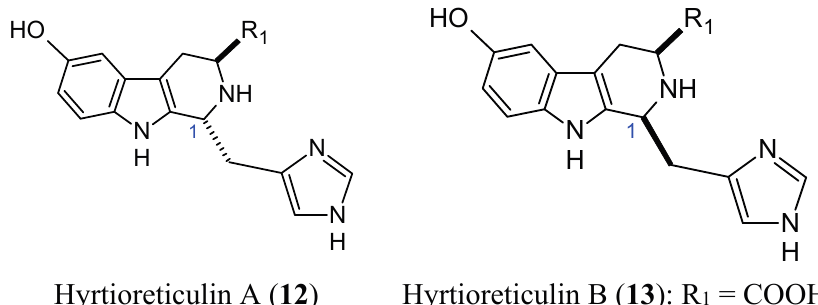
Figure 4. Chemical structures of hyrtiorecticulins analogs.